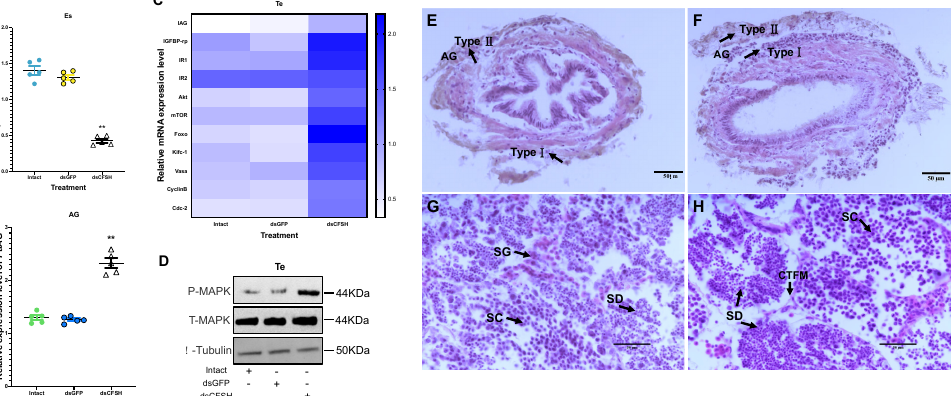
Figure 3. Effects of long-term dsPtCFSH injection on gene and protein expression of P. trituberculatus . ( A ) The efficacy of gene knockdown in the long-term PtCFSH silencing experiment was evaluated by qRT-PCR in the eyestalk. ** indicates acceptance p < 0.01 . ( B ) Effect of dsPtCFSH on PtIAG in AG tissue. The expression levels of PtIAG were examined in the intact group and after the in vivo injection of dsGFP and dsPtCFSH. ** indicates acceptance p < 0.01 . ( C ) Effect of dsPtCFSH on a series of genes in the testis. The heatmap levels of PtIAG , PtIGFBP -rp, PtIR1 , PtIR2 , PtAkt , PtmTOR , PtFoxo , PtKifc -1, PtVasa , PtCyclinB , PtCdc -2 were examined in the intact group and after the in vivo injection of dsGFP and dsCFSH. Different colors of the same tested gene between the experimental and control groups indicated significant differences. The darker the color in the heat map, the higher the relative expression of the tested genes and vice versa. ( D ) Effect of dsPtCFSH on phosphorylated-MAPK in testis. Phosphorylated MAPK, total MAPK and β -tubulin were detected in the intact group, dsGFP and dsPtCFSH injection groups, with T-MAPK and tubulin serving as internal references. ( E ) Histological sectioning and H&E staining of AG after dsGFP injection. The arrows indicate type I and II AG cells, and the scale bar is marked in the lower right corner. ( F ) Histological sectioning and H&E staining of AG after dsPtCFSH injection. The arrows indicate type I and II AG cells, and the scale bar is marked in the lower right corner. ( G ) Histological sectioning and H&E staining of the testis after dsGFP injection. The arrows point to the spermatogonia (SG), spermatocytes (SC) and spermatid (SD), respectively. The scale bar is shown in the lower right corner. ( H ) Histological sectioning and H&E staining of testis after dsPtCFSH injection. The arrows point to the spermatogonia (SG), spermatocytes (SC) and spermatid (SD), and connective tissue fibers muscle (CTFM), respectively. The scale bar is shown in the lower right corner. Vertical bars represent means ± SEM (n = 5). Significant differences among stages are indicated by different letter labels (one-way ANOVA followed by post hoc Tukey’s multiple group comparison p <